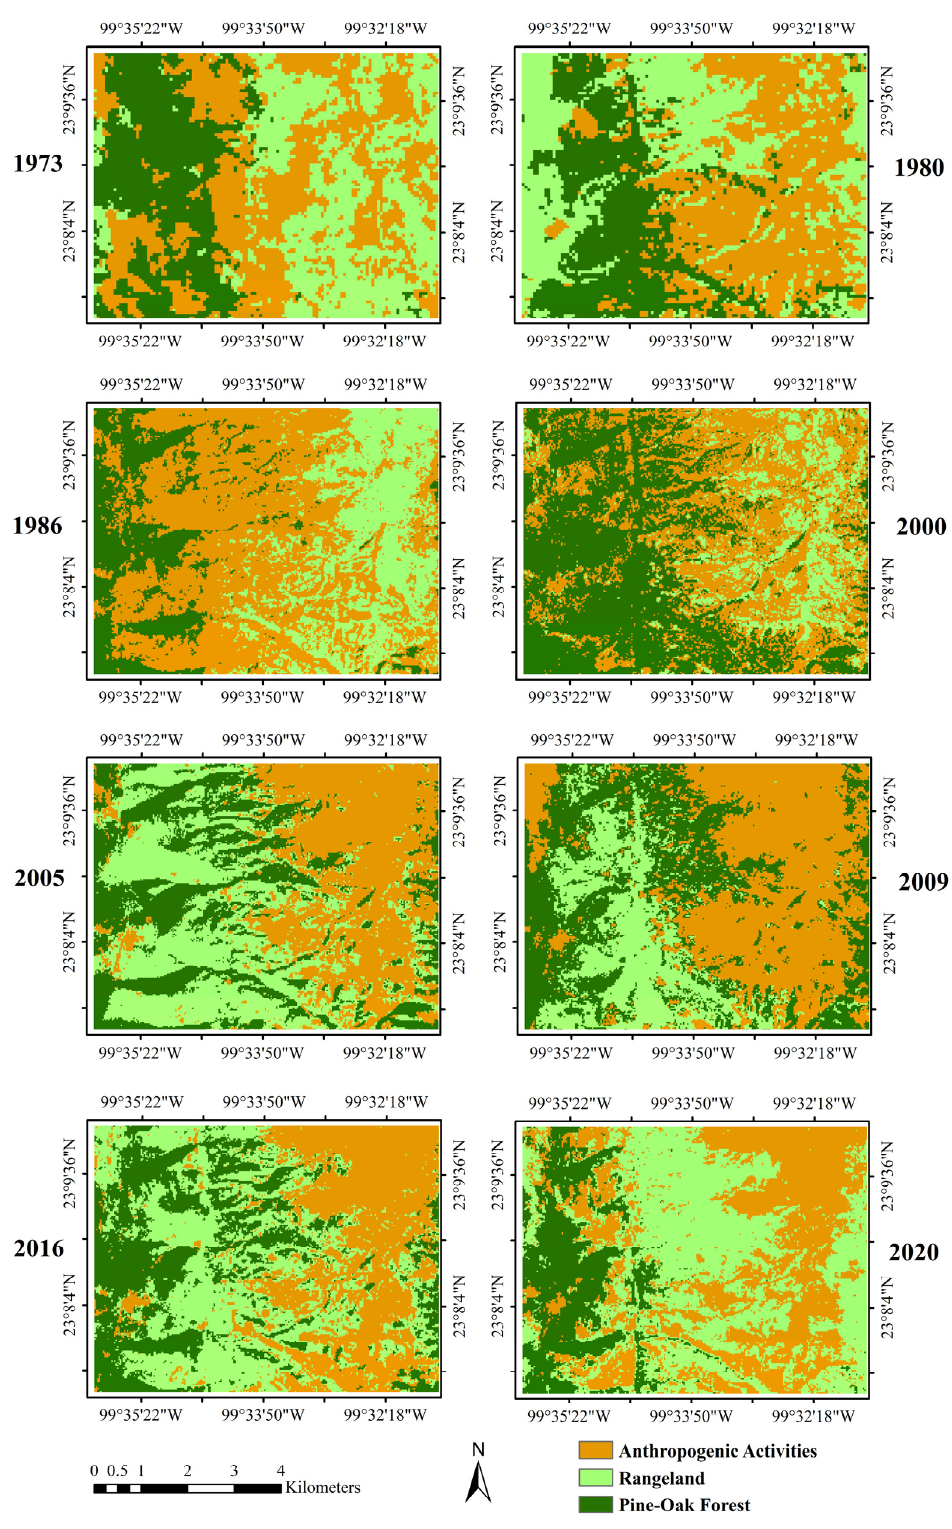
Figure A4. Land use coverage in 1973, 1980, 1986, 2000, 2005, 2009, 2016, and 2020, San Vicente,